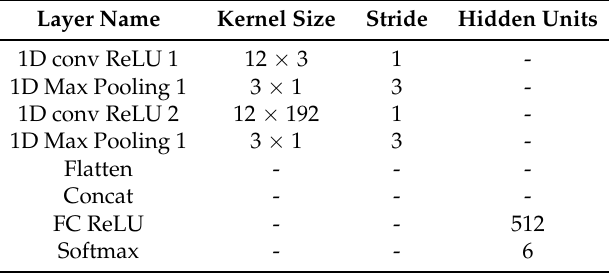
Table 6. Detailed layer